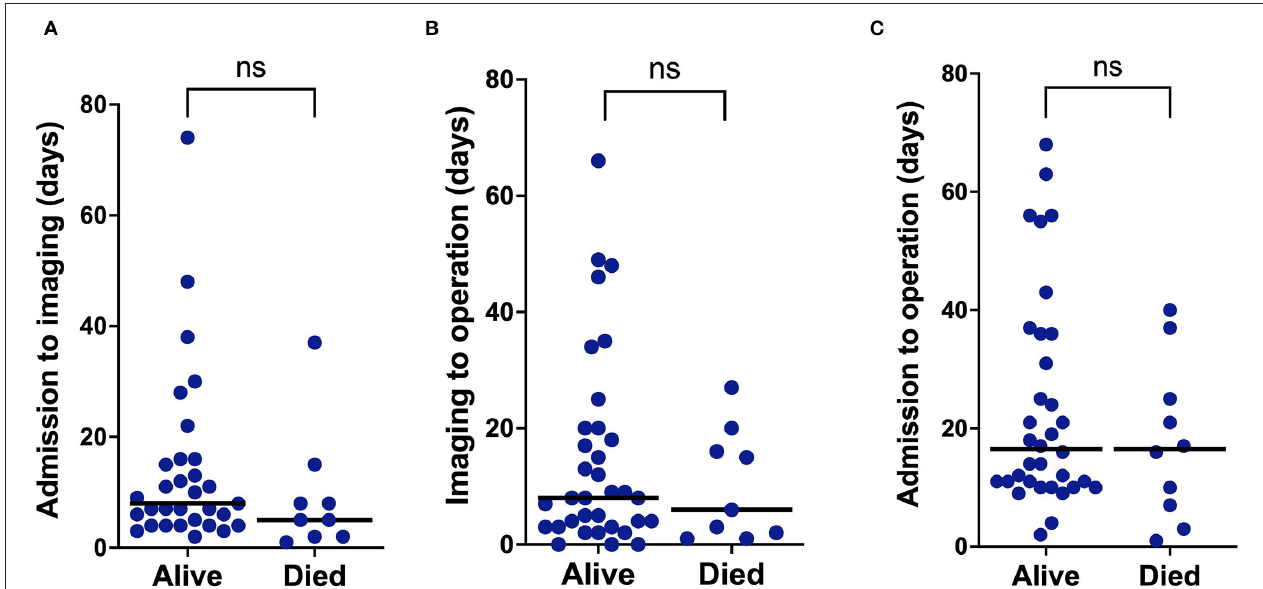
FIGURE 1 | Plots of the time interval between (A) start of the episode to diagnostic imaging, (B) time from diagnostic imaging to operation, and (C) time from the start of the episode to operation, comparing patients who were alive or had died within 30 days of operation. and operation [8 (3–20) vs. 6 (1.5–18) days; p = 0.53] or